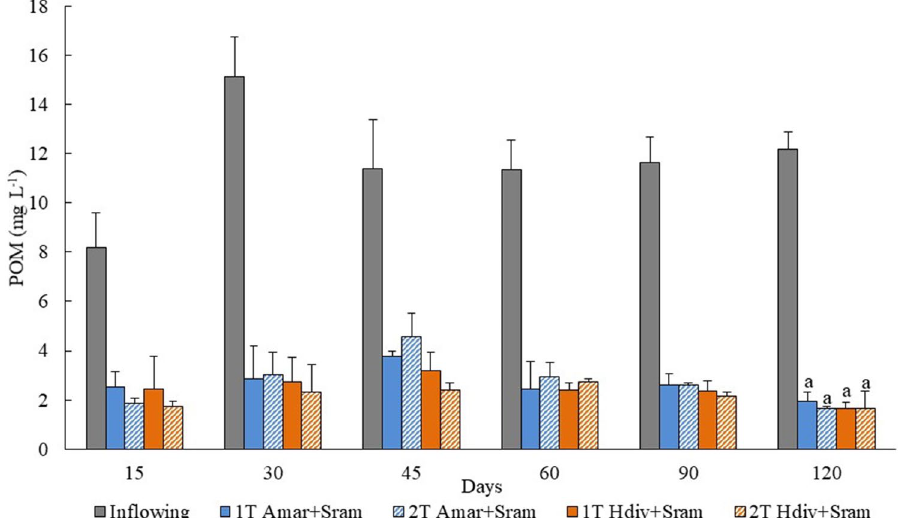
Figure 1. Particulate organic matter (POM) quantified in the inflowing and outflowing efluent of IMTA designs tested in the present study using as extractive species polychaetes ( Arenicola marina —Amar—and Hediste diversicolor —Hdiv) and halophytes ( Salicornia ramosissima —Sram) cultured in the same tank (1 T) or in two separate tanks (2 T). Average values ± SD (n = 5). Statistical analysis performed only at 120 days when the biomass of extractive species was evaluated. No significant differences ( p < 0.05) between IMTA designs were